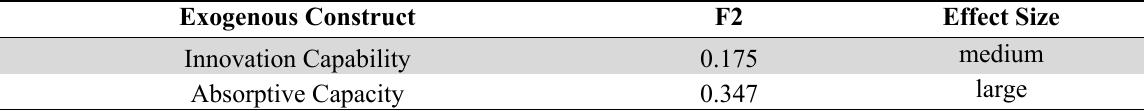
Effect size Exogenous Construct F2 Effect Size Innovation Capability 0.175 medium Absorptive Capacity 0.347